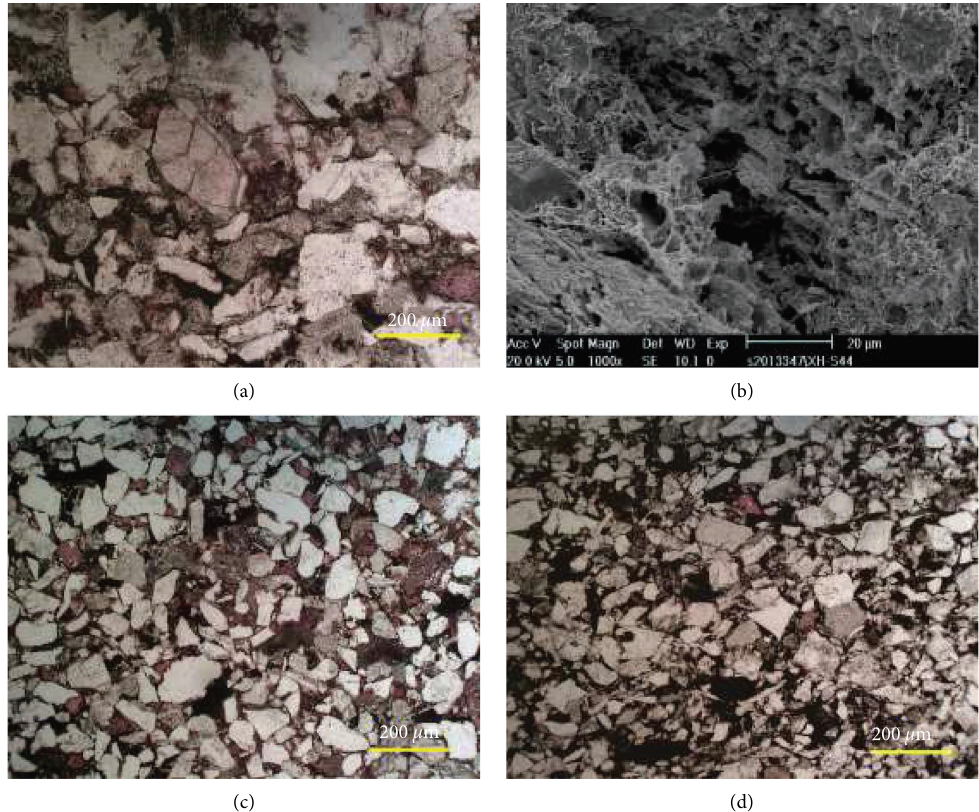
Figure 3: Microscopic characteristics of Chang 6 long stone sandstones in Yanchang Formation. (a) Fine sandstone, feldspar fracture, and (b) dissolved pores in feldspar grains. (c) Mostly angular-subangular fne-grained feldspathic sandstone. (d) Subangular fne-grained lithic feldspathic sandstone.